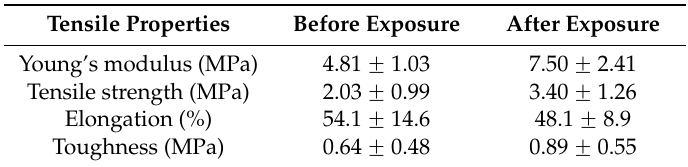
Table 3. Tensile properties of nylon 6 non-woven fiber mats electrospun from 20 wt % solutions before and after formic acid vapor exposure for 30 min at room temperature.